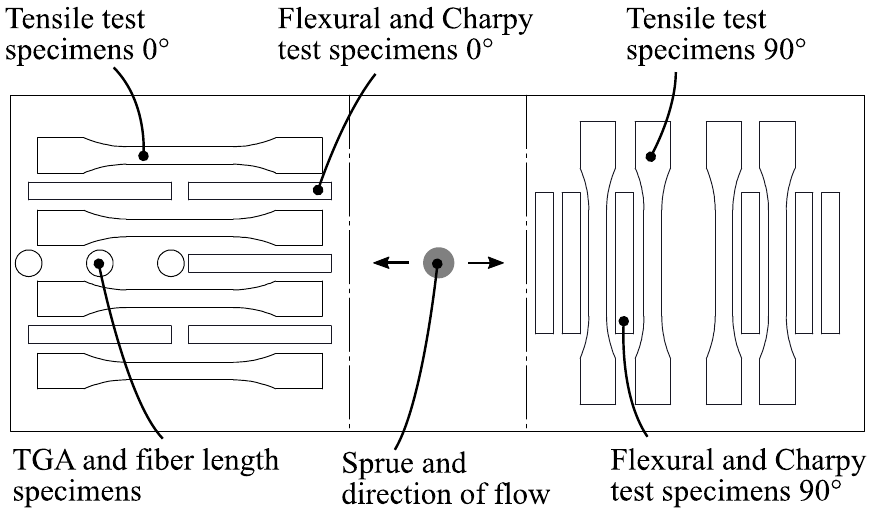
Figure 4. Cutting pattern with specimen locations.